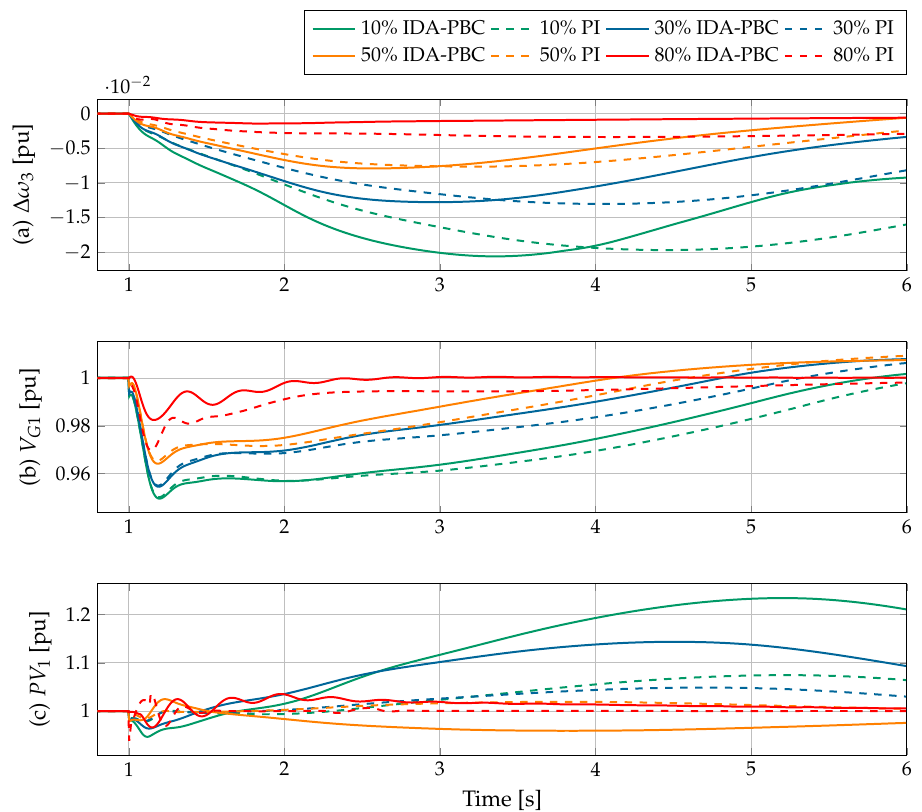
Figure 7. Response of the test system to the abrupt disconnection of generator 4: ( a ) rotor speed deviation of generator 3, ( b ) terminal voltage of generator 1, and ( c ) active power of PV plant